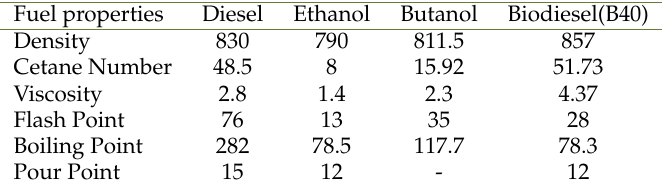
Table 2. Properties value of Biodiesel (B40), Diesel, Ethanol and Butanol fuel